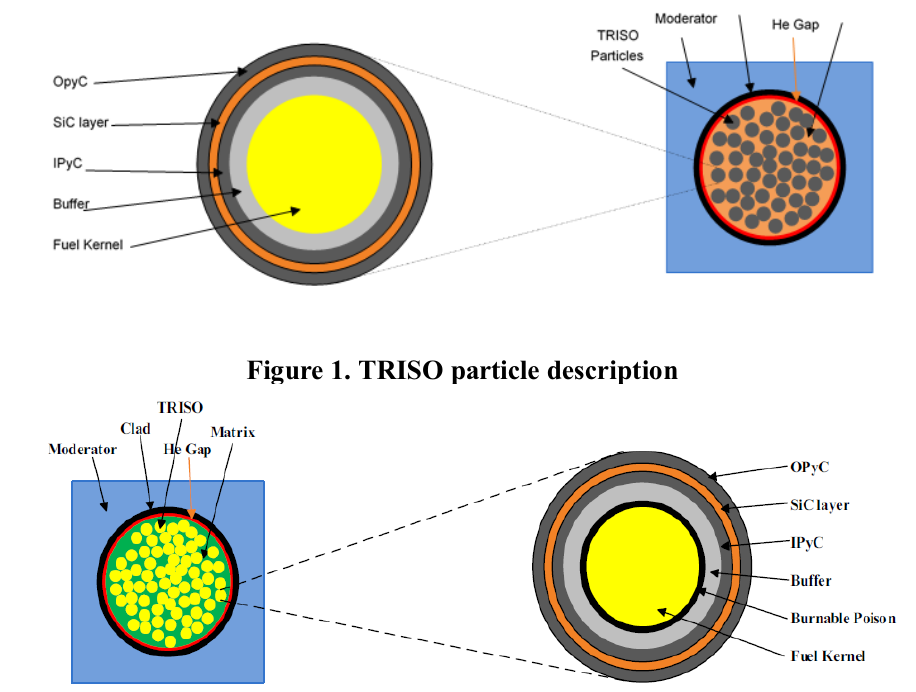
Figure 2. QUADRISO particle description